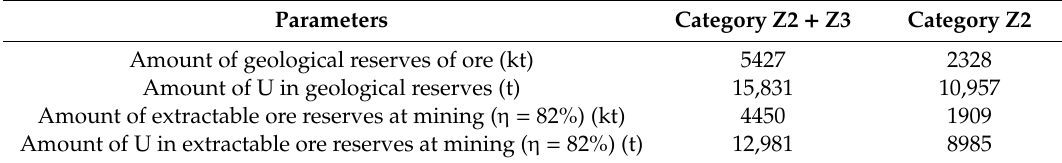
Table 5. The amount of geological and extractable reserves at the deposit of Kuriskova.